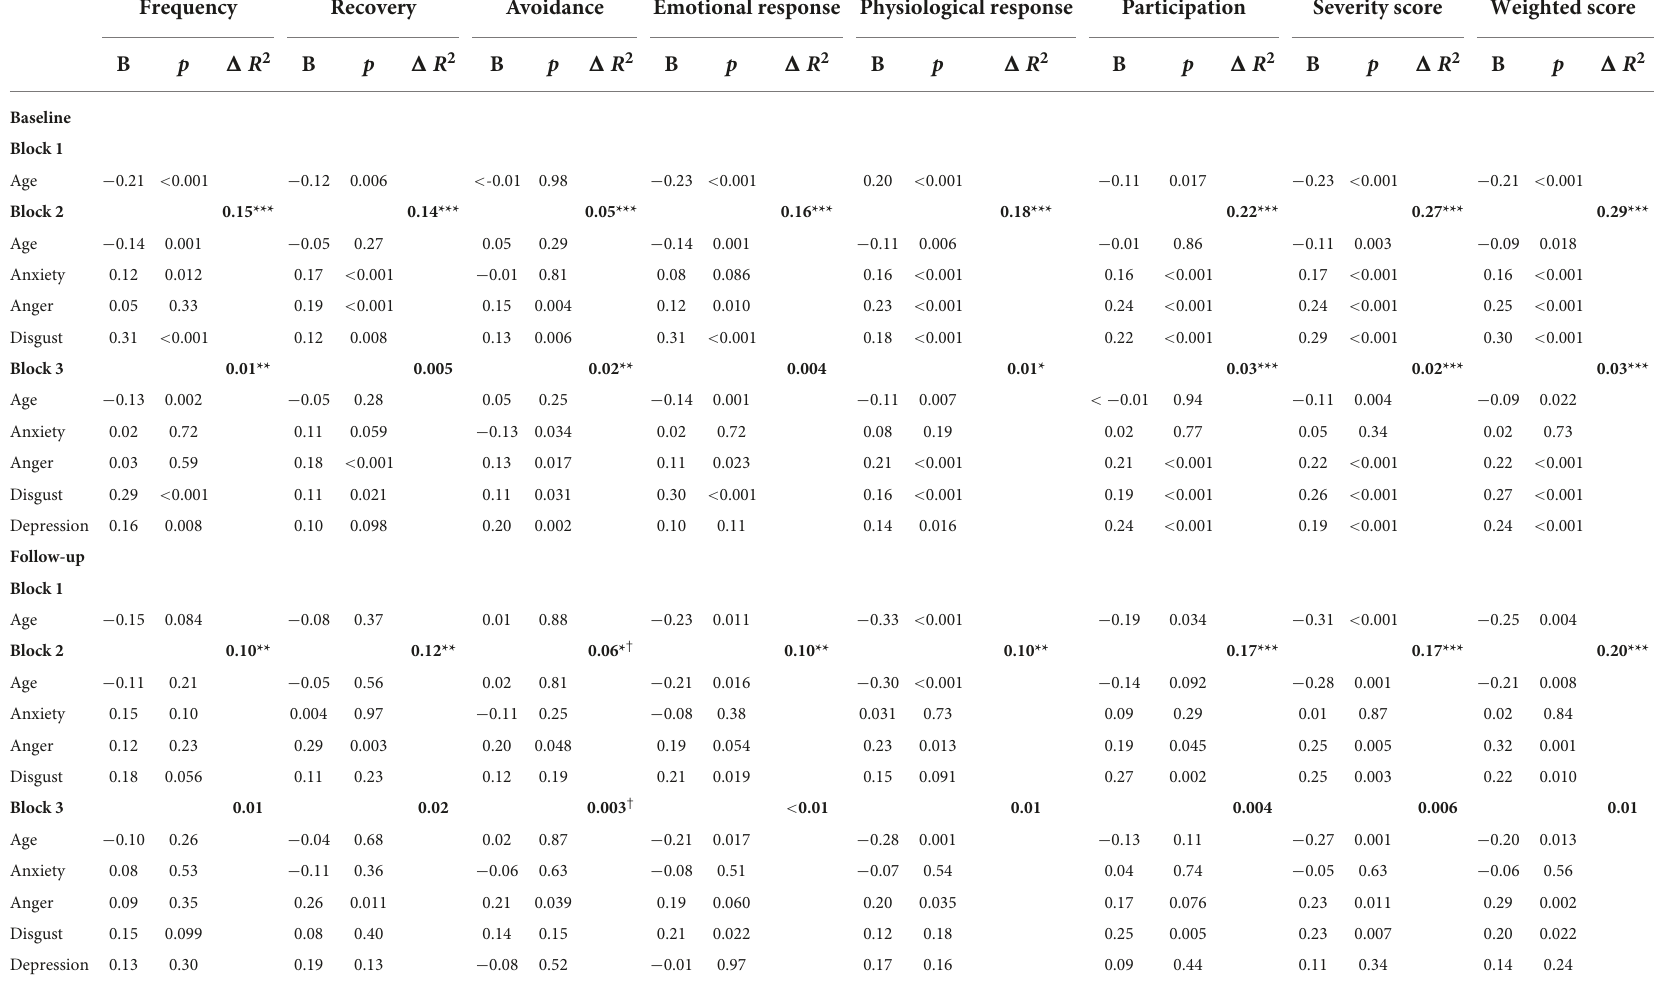
TABLE 10 Summary of hierarchical regression models for predicting misophonic response cross-sectionally (at baseline) and longitudinally (at follow-up) in misophonia